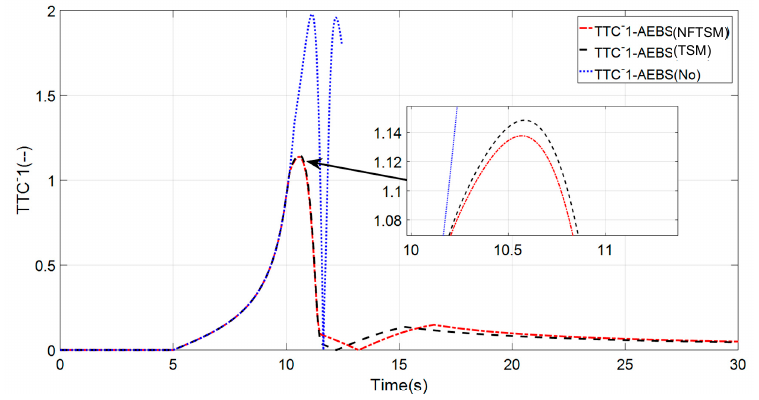
Figure 4. Comparison of vehicle acceleration.